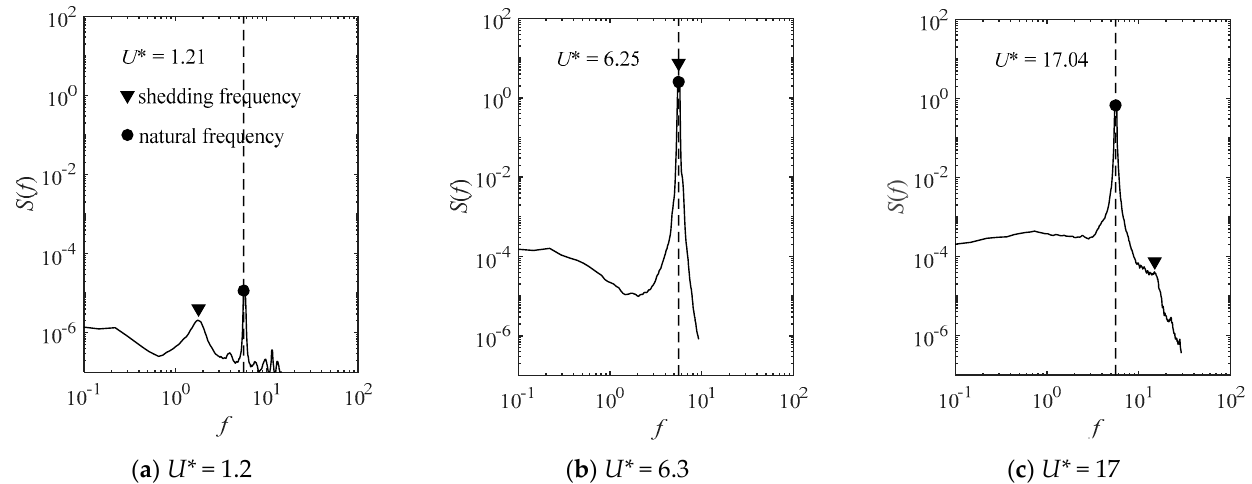
Figure 8. Power spectral densities of octagonal tower (tower-only case).